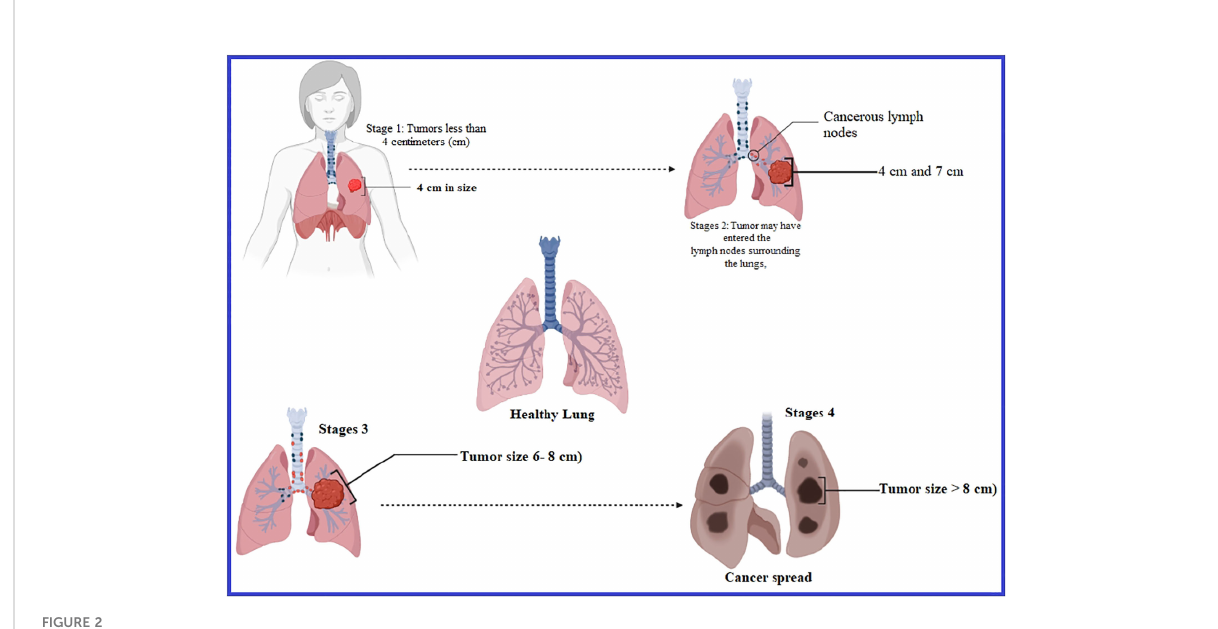
FIGURE 2 Development stages of lung